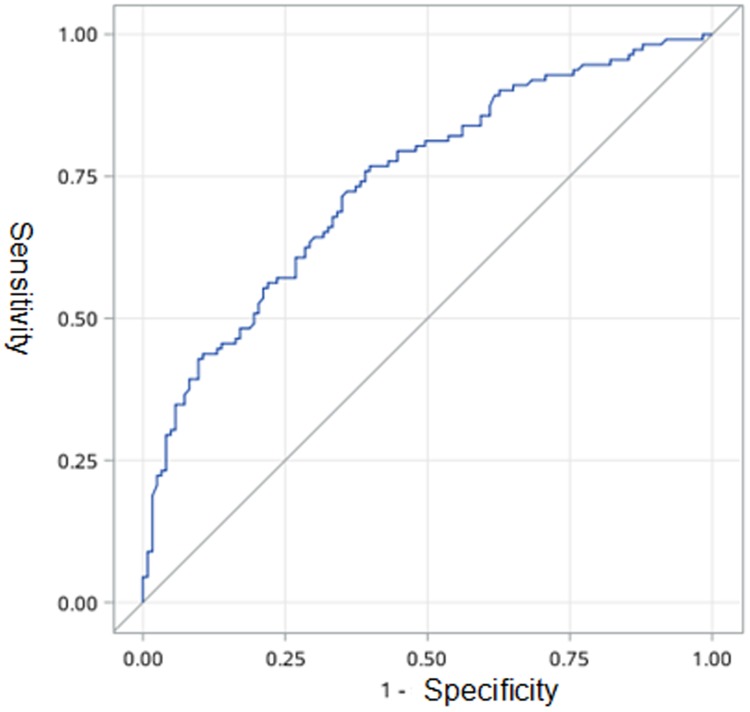
Receiver operator characteristic curve for the model which composed by age, gender, smoking history, air bronchogram, pleural tags, pleural and liver metastasis to predict EGFR mutation status.The area under the curve is 0.741.